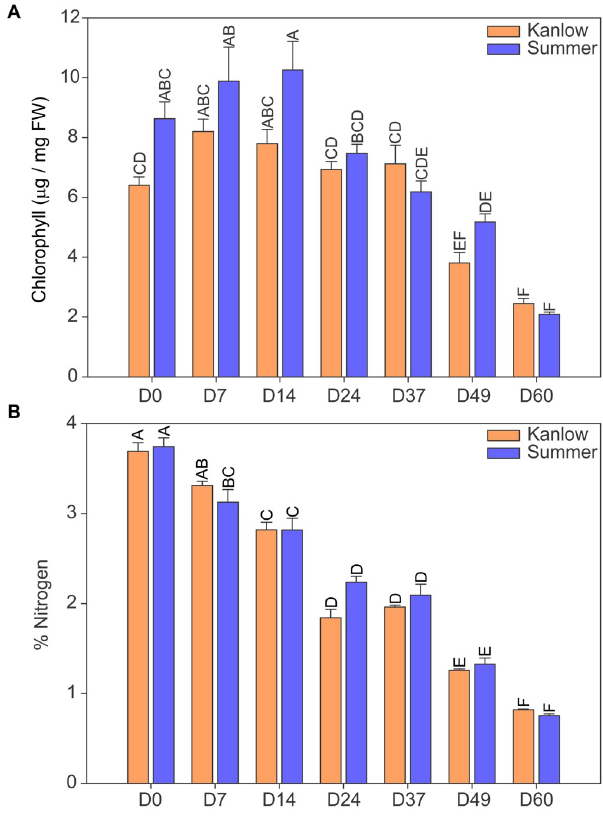
Fig 1. Changes in leaf components over time. (A) chlorophyll and (B) total N. The 4 th leaf was harvested from upland Summer and lowland Kanlow switchgrass cultivars starting at emergence (D0) followed by six successive harvests until late senescence (D60). Summer (blue bars); Kanlow (orange bars). Error bars are ± s.e. Different letters over each bar denote statistical significance at P �